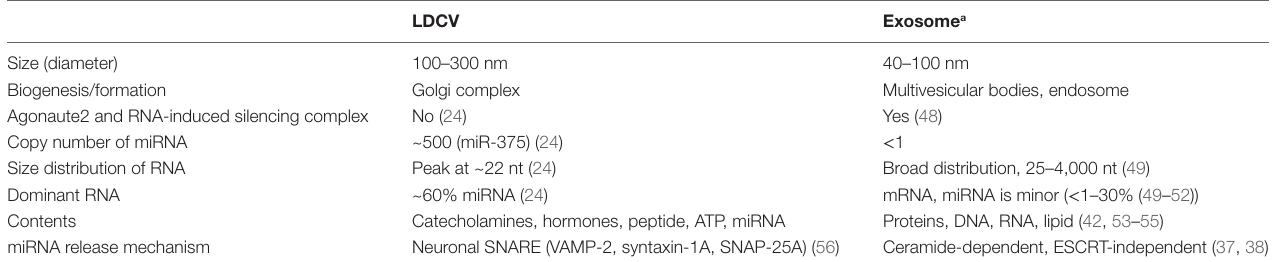
TABLe 1 | Comparison of large dense-core vesicle (LDCV) and exosome a